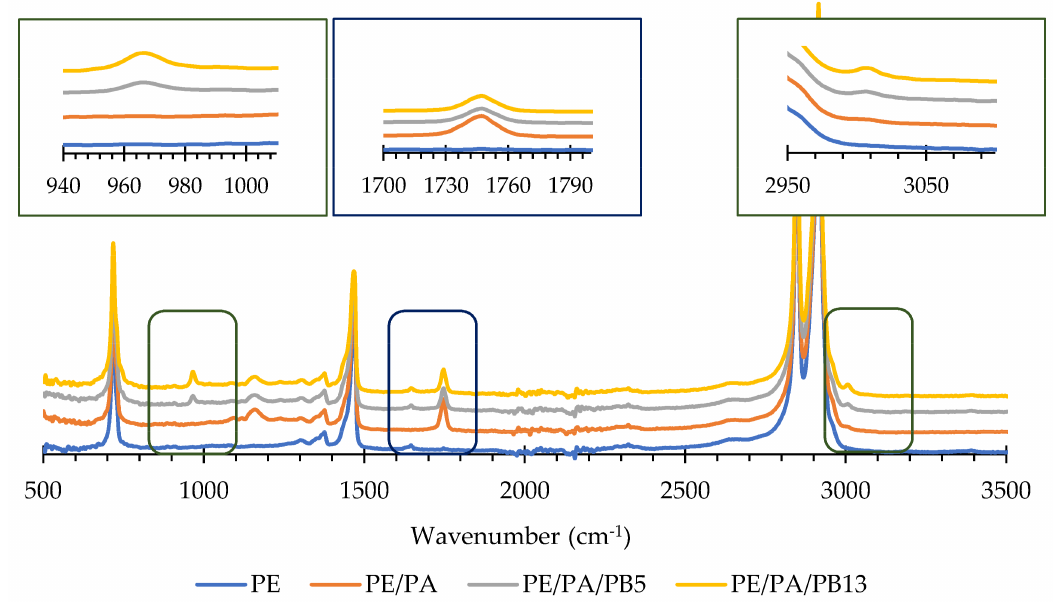
Figure 2. Attenuated total reflectance-Fourier transform infrared spectroscopy (ATR-FTIR) spectra of PE, PE/PA, PE/PA/PB5 and PE/PA/PB13